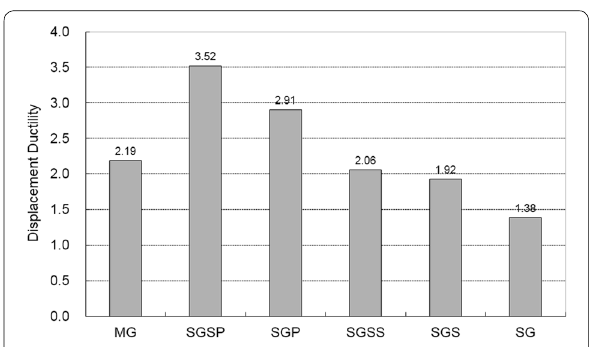
Fig. 13 Comparison of displacement ductility for the specimen.